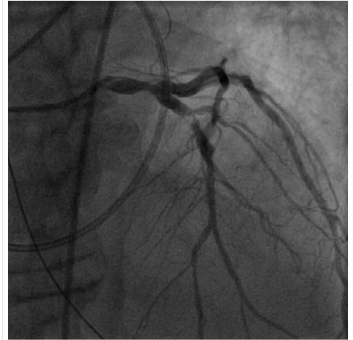
Figure 2. Right anterior oblique coronary angiography demonstrating 80% left main coronary artery and 90% proximal left anterior descending coronary artery stenosis.